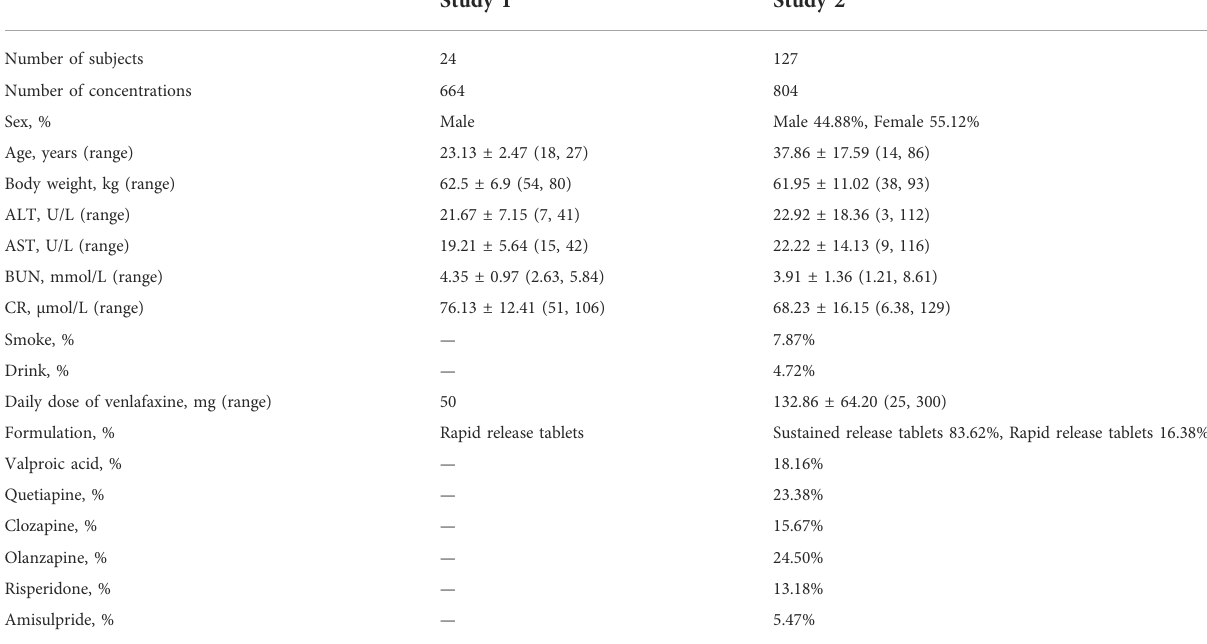
TABLE 1 Demographic and clinical summary of participants in the pooled analysis. Study 1 Study 2